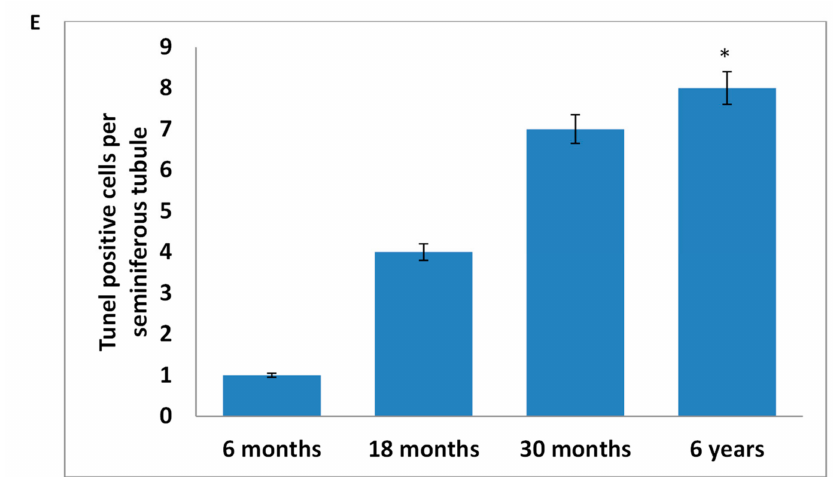
Figure7. TunnelassayoftestisofdifferentagesofDatongyak. ( A )6months. ( B )18months. ( C ) 30 months. ( D ) 6 years. TUNEL-positive germ cells were rare in 6 months testes. The TUNEL-labeled apoptotic cells were counted, and the apoptosis rates were determined by calculating the average percentage of the total cells per seminiferous tubule. The symbol (*) indicated a significant increase from 6 months ( < 0.05).